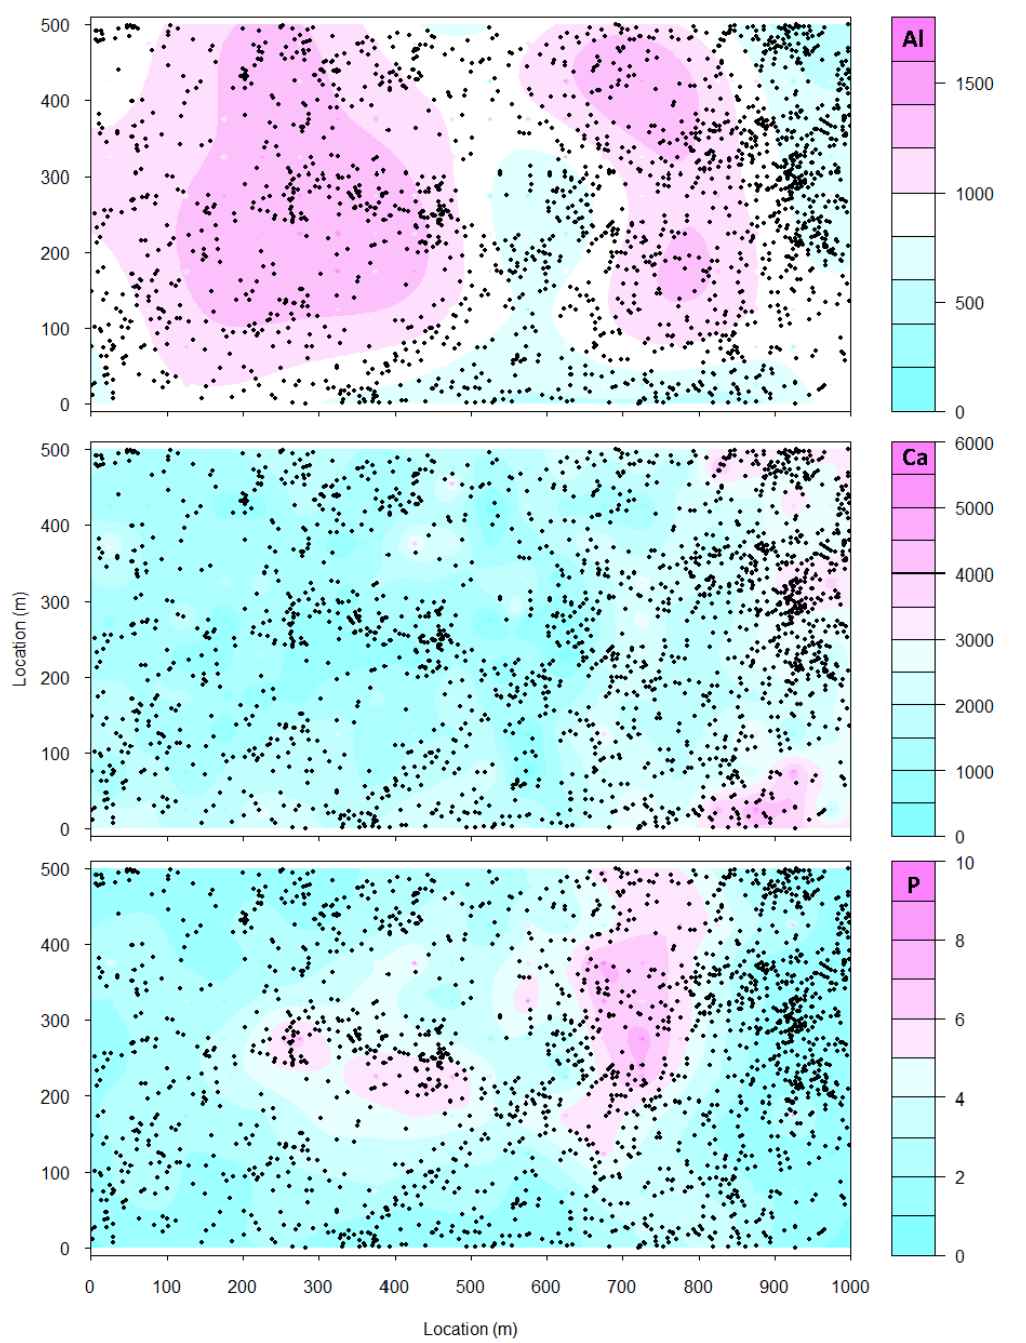
Figure 6. Kriged surfaces of the concentration (mg/kg) of aluminum (Al; top), calcium (Ca; center), and phosphorus (P; bottom) in the 50-hectare plot at Barro Colorado Island, Panamá. Contours were estimated for a regular grid (5-m spacing) based on data from samples taken at approximately 50-m intervals. Interpolated values of mineral concentrations were estimated at individual points (locations of trees) shown on the